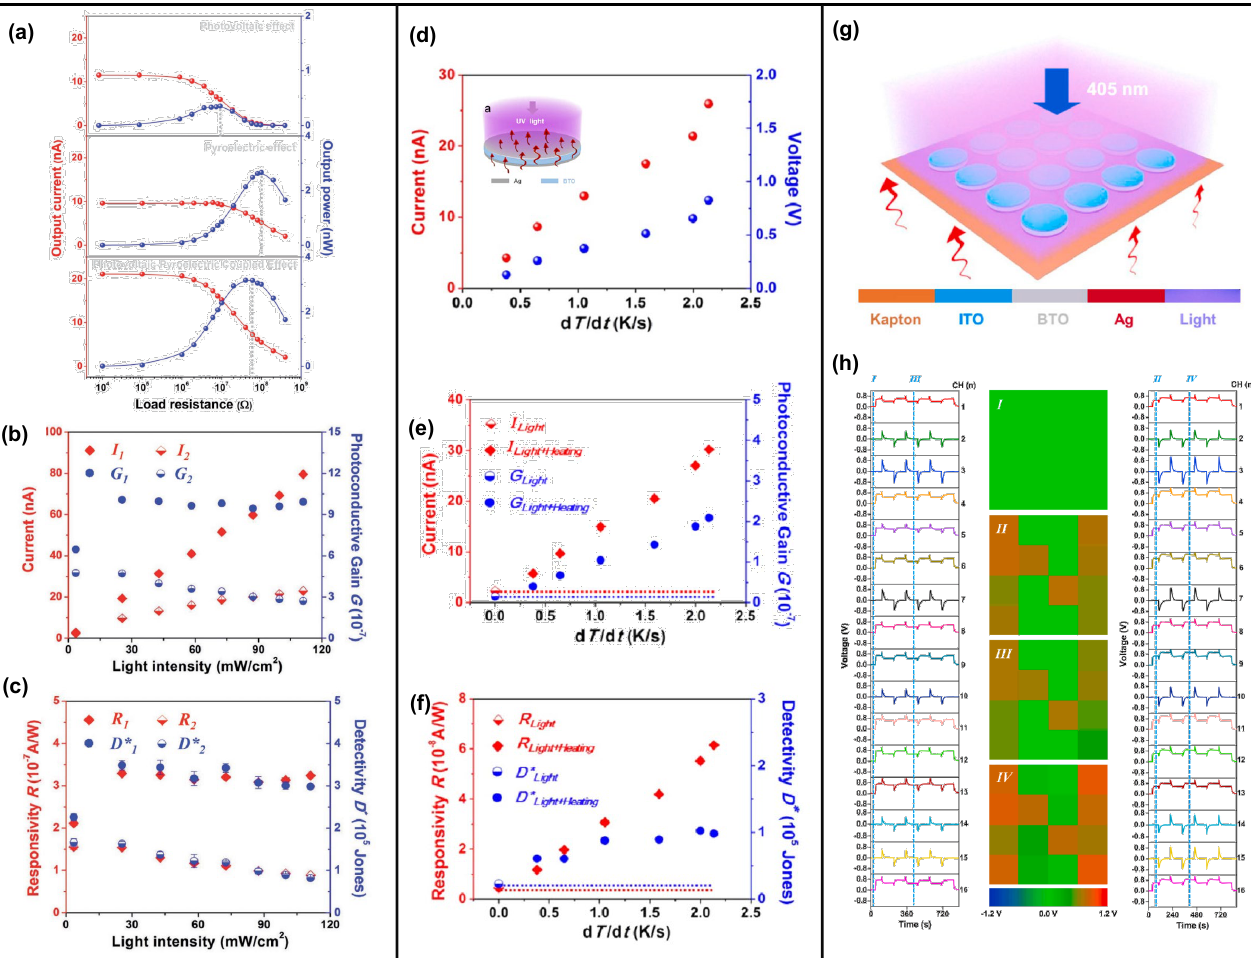
Figure 13. ( a ) Dependence of output current and output power of ITO/BTO/Ag device regarding the photovoltaic effect, the pyroelectric effect, and the photovoltaic–pyroelectric coupled effect on loading resistance under 405 nm illumination; ( b ) Relationship of short-circuit current and photoconductive gain G with light intensity regarding the photovoltaic–pyroelectric-coupled effect and the photovoltaic effect; ( c ) Responsivity and detectivity with light intensity regarding the photovoltaic–pyroelectric coupled effect and the photovoltaic effect. Reproduced with permission from [94]. Copyright 2017 Wiley; ( d ) Dependence of output current and voltage on temperature change rate dT/dt for Ag/BTO/Ag photodetector. Inset: Schematic illustration of Ag/BTO/Ag photodetector in responding to UV light under heating conditions; ( e , f ) Relationship of output current and photoconductive gain, responsivity, and detectivity with temperature change rate dT/dt. Reproduced with permission from [95]. Copyright 2017 Elsevier; ( g ) Schematic of the designed flexible photodetector system based on the ITO/BTO/Ag structure; ( h ) V-t curves and mapping images of the self-powered photodetector system under different conditions. Reproduced with permission from [102].